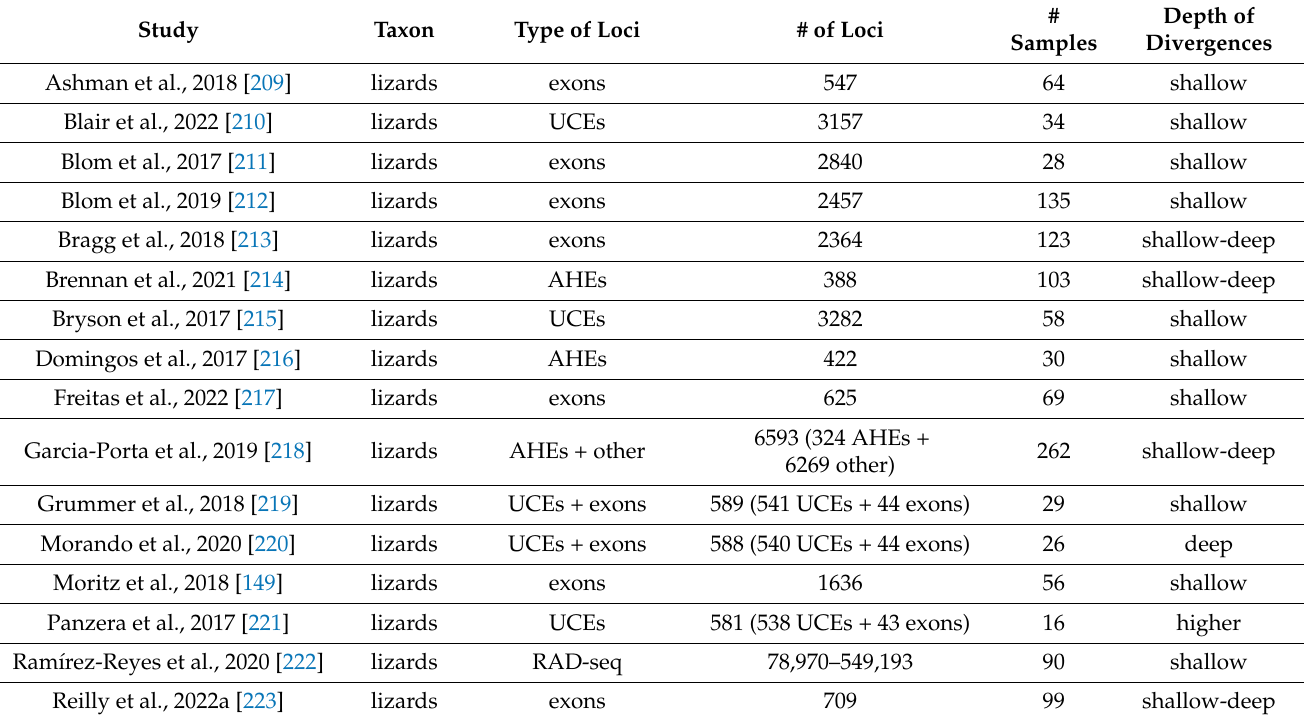
Table 1. Phylogenomic studies of non-avian reptile clades published between 2017 and 2022 that used at least 100 DNA sequence